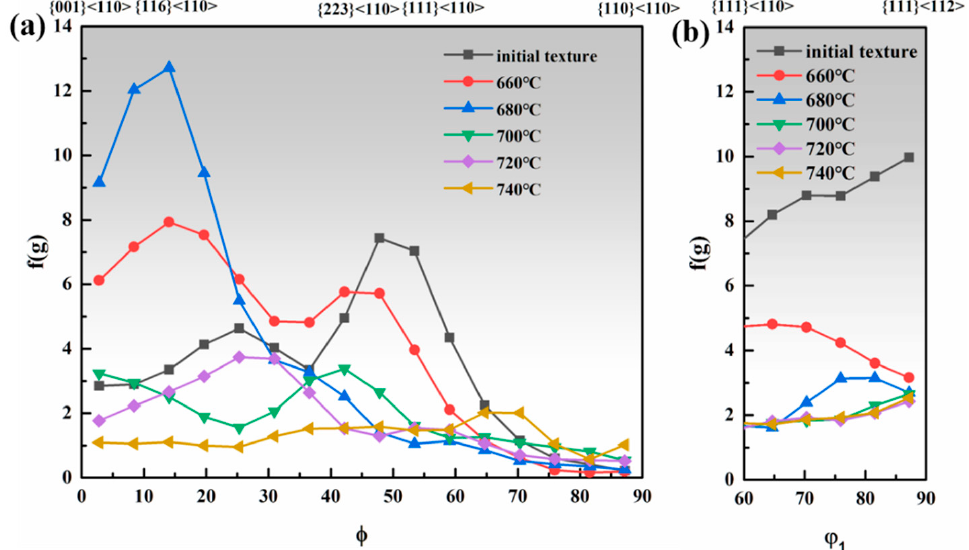
Figure 3. The orientational density of the α -fiber and γ -fiber textures at various continuous annealing temperatures: ( a ) α -fiber texture and ( b ) γ -fiber texture.